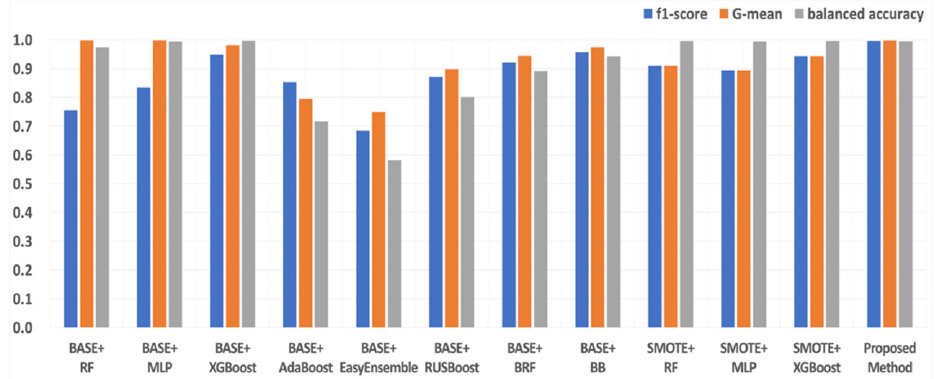
Figure 7. Comparison of the performance of different sampling methods.